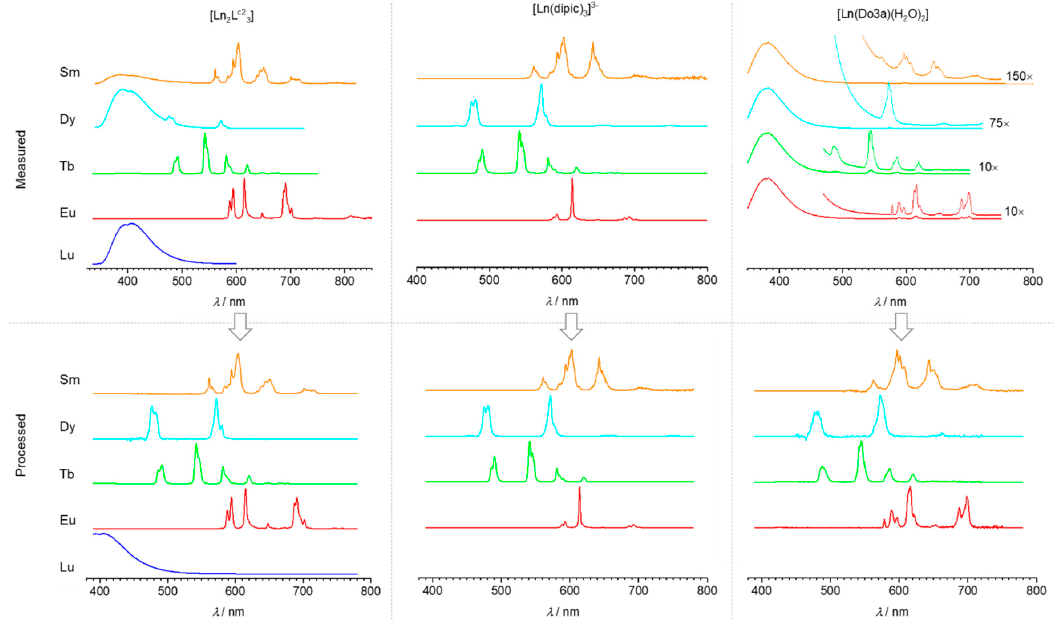
Figure 1. Spectral data in normalised counts per second (measured) and final cropped relative spectral irradiances (processed) for the 3 series of complexes.